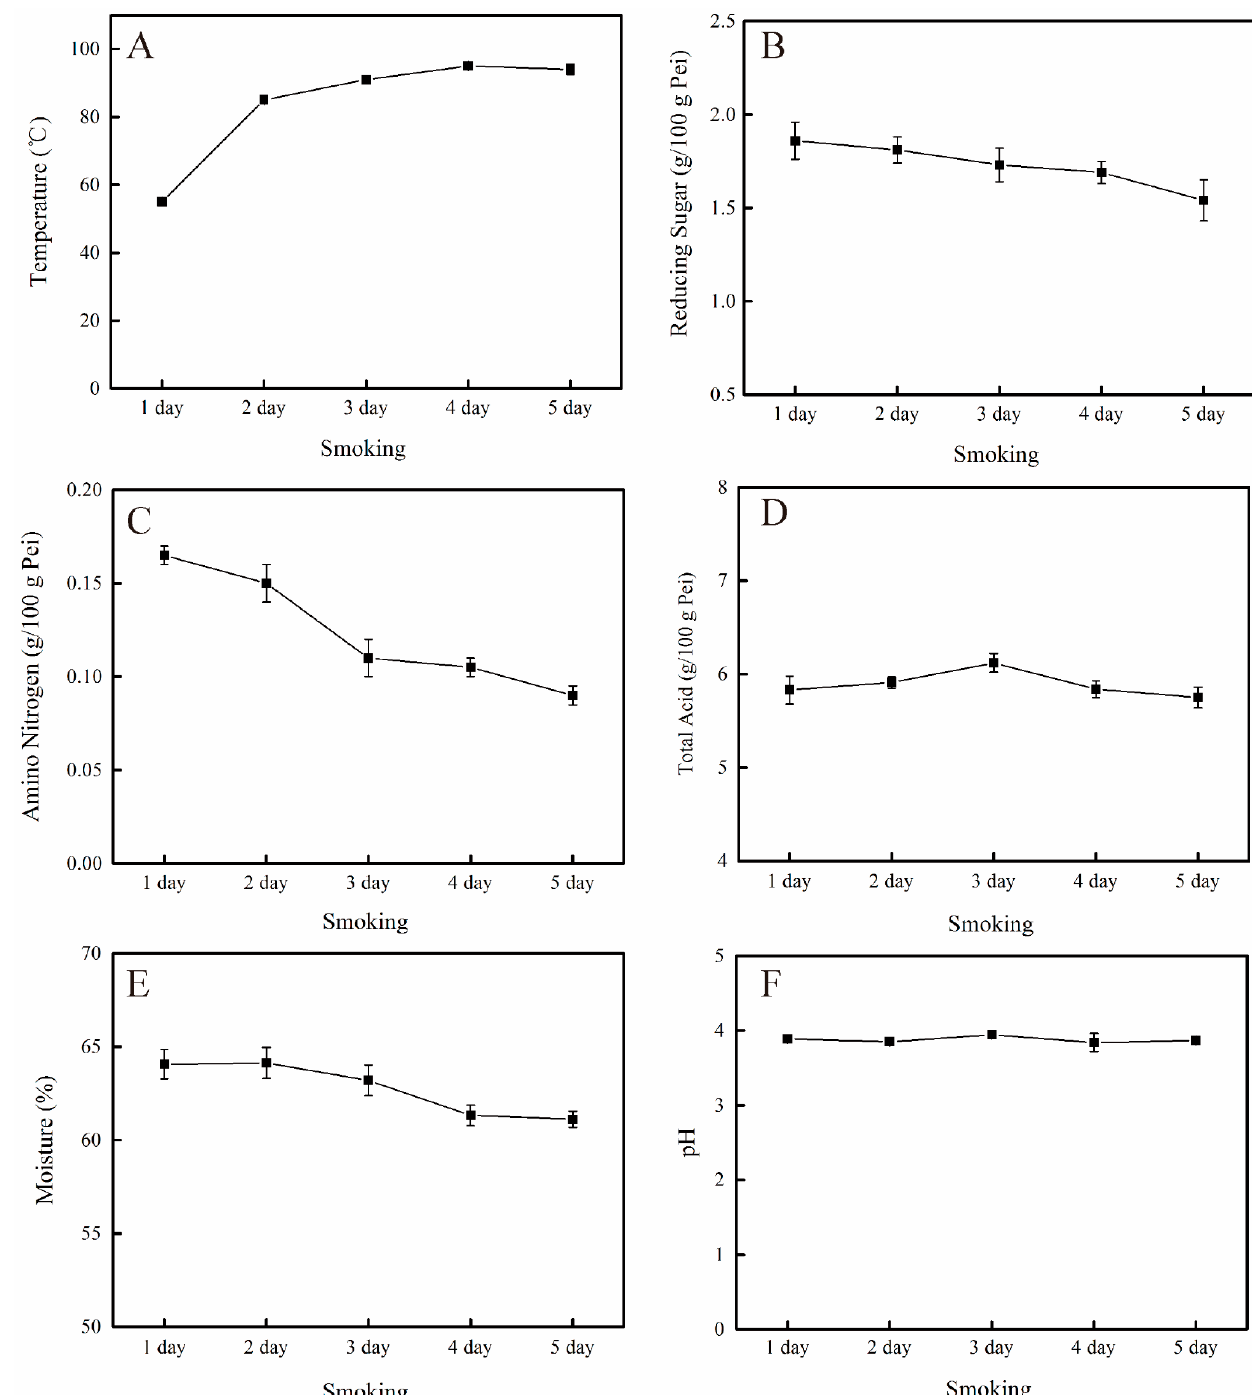
Figure 2. Changes in physicochemical indexes during the smoking process of Shanxi aged vinegar. ( A )–( F ) indicates the changes of temperature, reducing sugar, amino nitrogen, total acid, moisture and pH in the smoking process in turn.